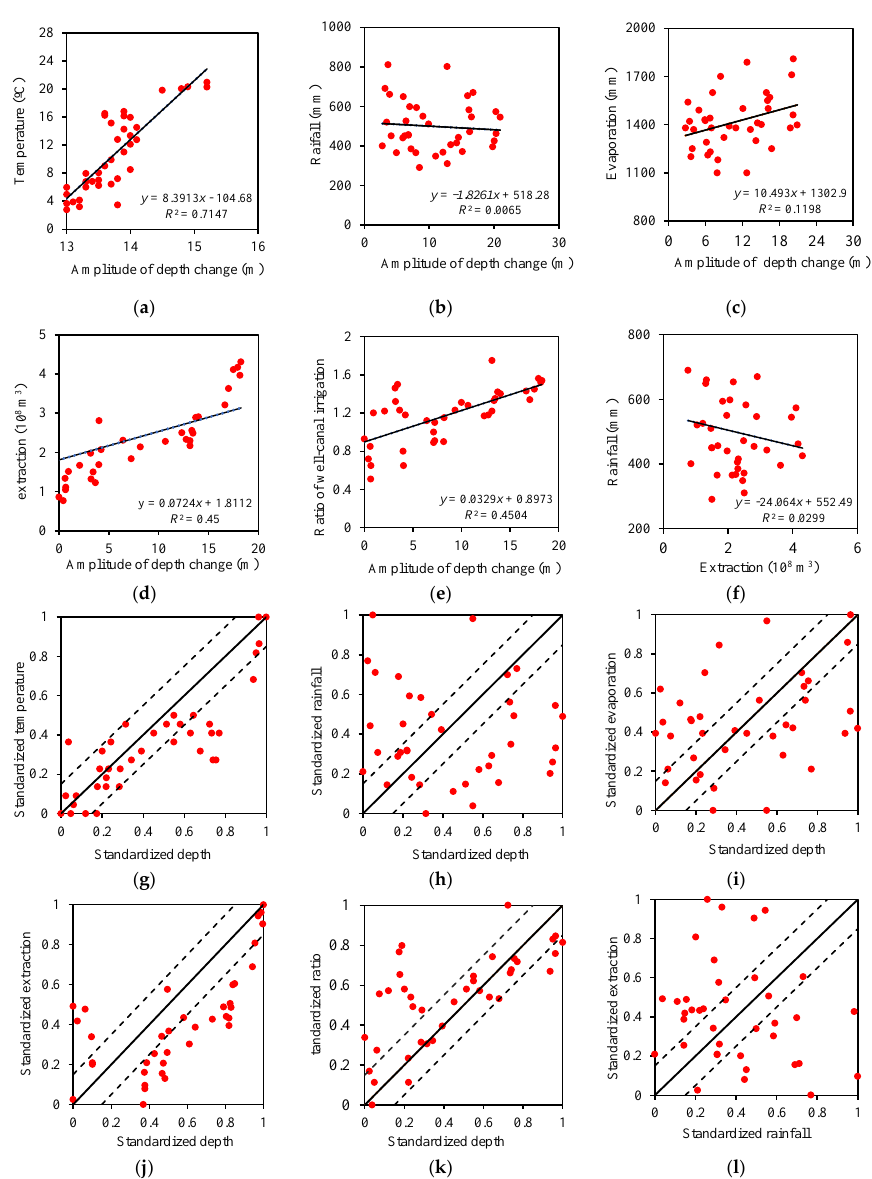
Figure 10. The correlation among different climate factors, human factors, and groundwater depths. ( a ) Temperature and depth, ( b ) rainfall and depth, ( c ) evaporation and depth, ( d ) extraction and depth, ( e ) well-canal irrigation ratio and depth, and ( f ) rainfall and extraction. ( g – l ) 95% confidence interval of the correlation between the two dashed lines (1980–2017).